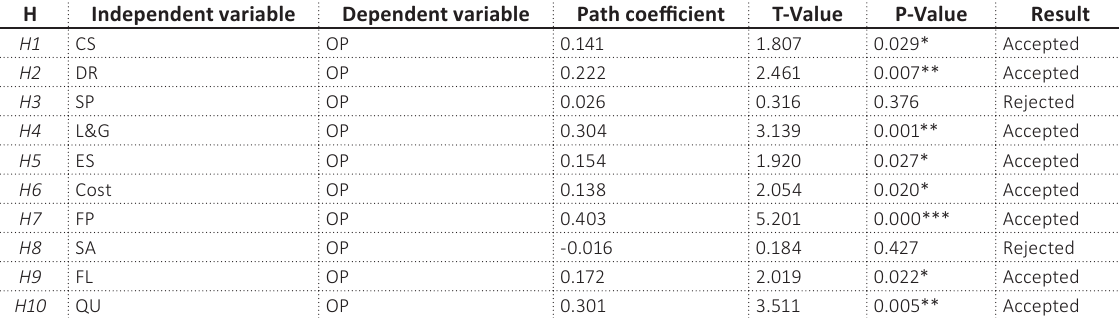
Table 5. Hypothesis